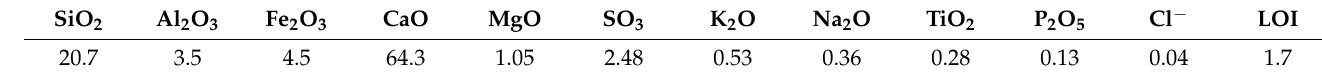
Table 1. Chemical composition of the cement